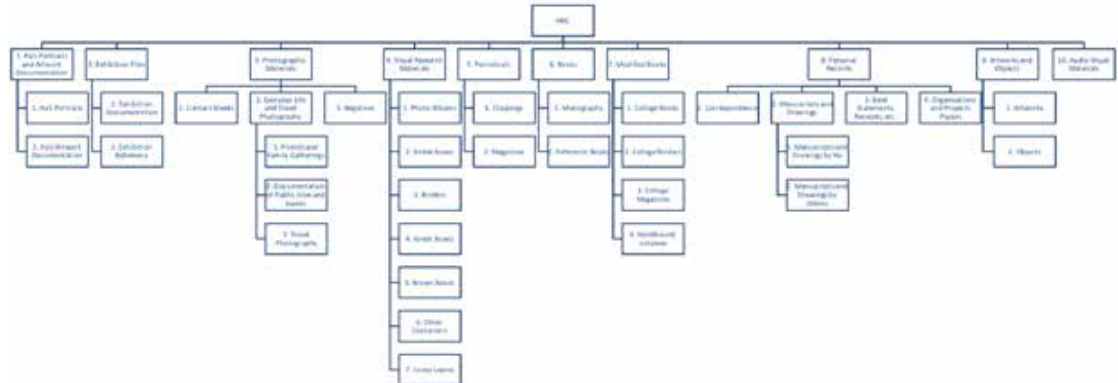
Figure 4: Archival tree of HBC Archive. Source: courtesy of Asia Art Archive.